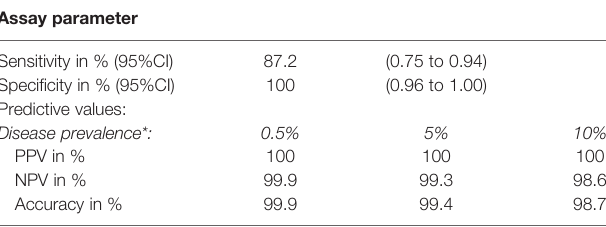
TABLE 2 | Saliva ELISA performance